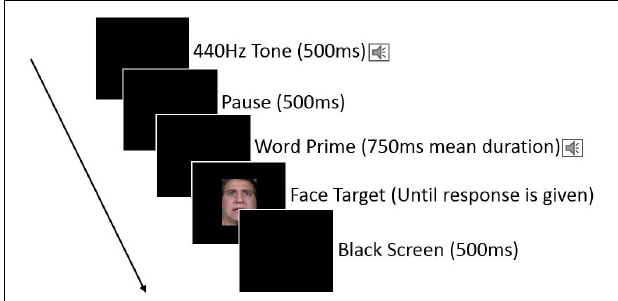
FIGURE 2 | Accuracy rates for categorizing face targets after priming by emotion words. Error bars represent standard error, and a star indicates a significance level of p < 0.05.